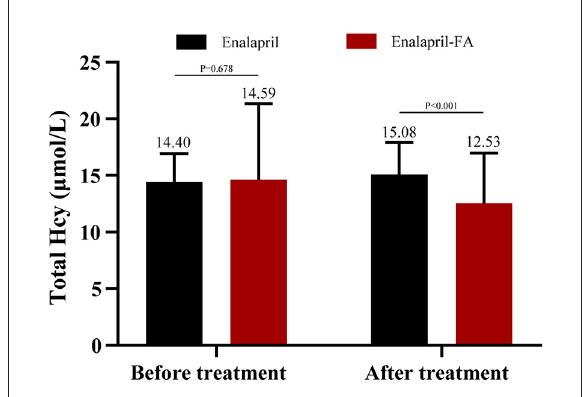
FIGURE2 Mean plasma levels of tHcy before and after treatment in matched cohort. Plasma tHcy levels were obtained in 239 patients in the enalapril group and 239 patients in the enalapril-FA group before treatment; in 177 and 216, respectively, after treatment. tHcy, total homocysteine; FA, folic